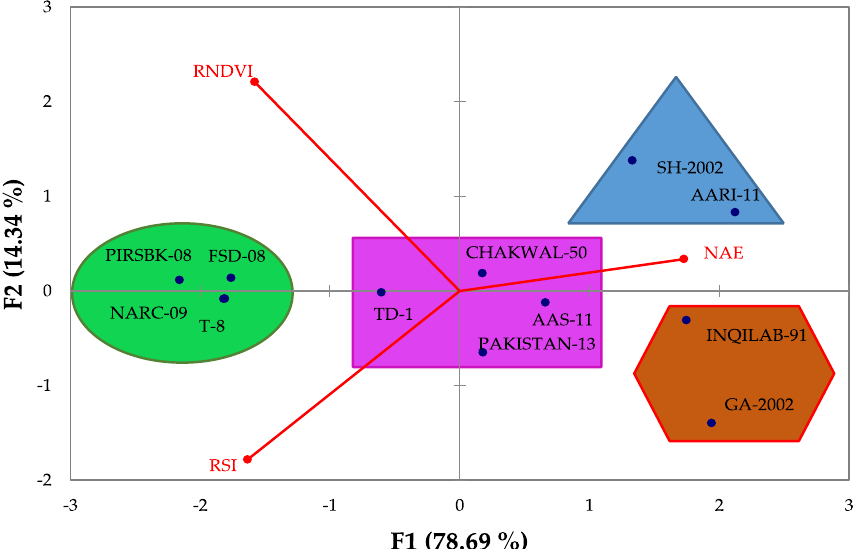
Figure 1. PCA analyses organized varieties at moderate N application (N60, 60 kg N/ha) into four groups represented by green (N-use efficient), pink (moderately N-use efficient), brown (moderately N-use inefficient) and blue (N-use inefficient) based on mean RSI, RNDVI and NAE.